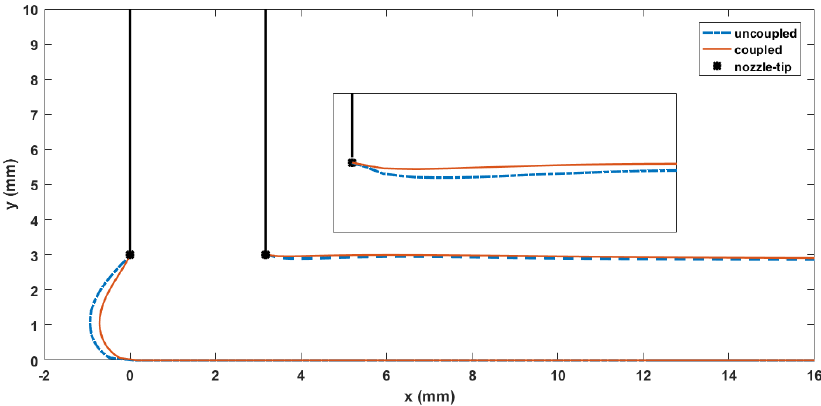
Figure 9. Free surface identifications of the planar deposition flow.